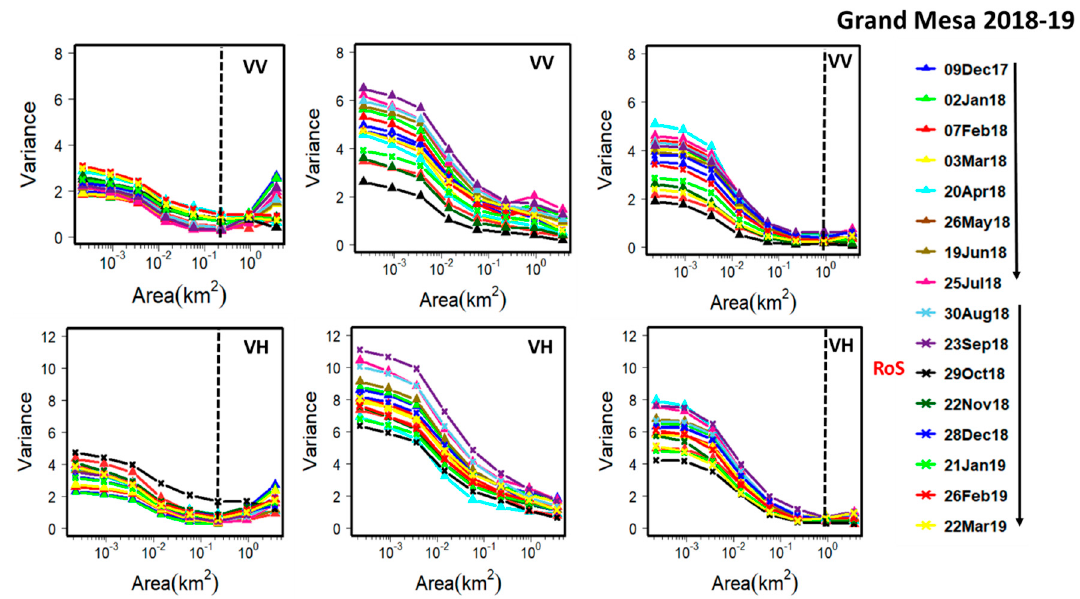
Figure 11. Temporal evolution of the spatial variance of Sentinel-1 BSC VV (top row) and VH (bottom row) in descending mode for grassland (left, A), mixed grassland and forest (middle, B), and evergreen forest (right, C) in Grand Mesa from December 2017 through March 2019 as a function of areal scale. RoS: Rain on Snow event as per SNOTEL observations (Figure S3b).